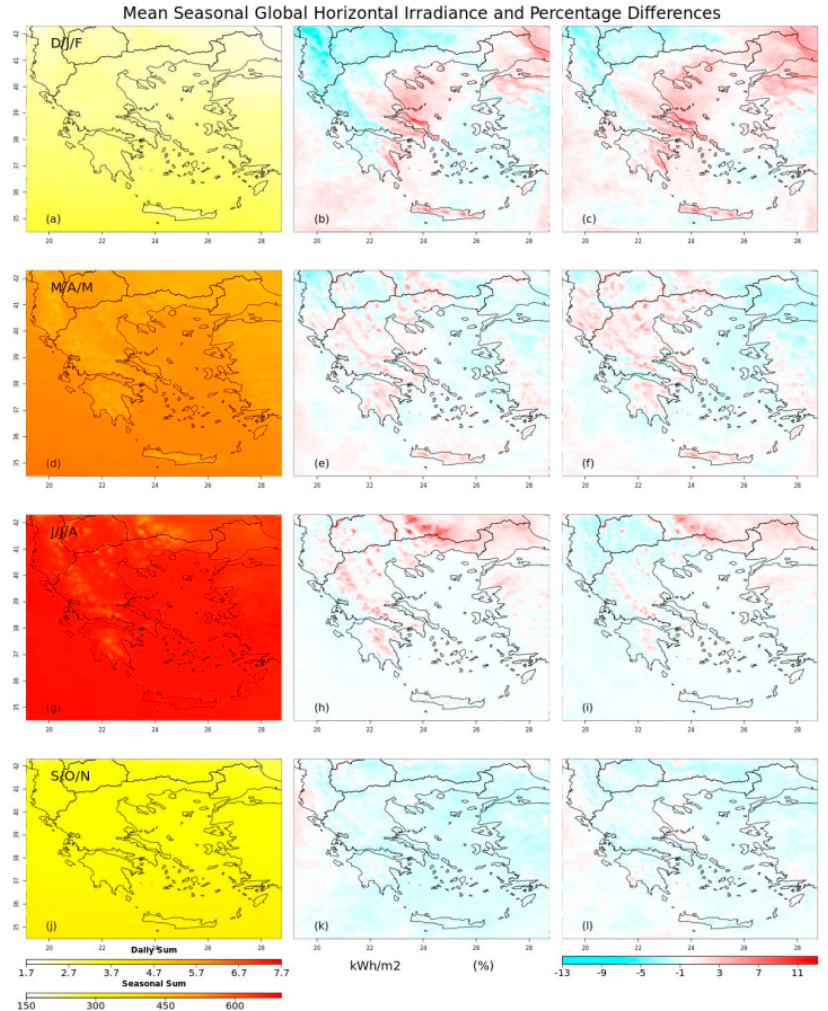
Figure 6. Mean seasonal GHI daily and annual sum ( a , d , g , f ) at historical period and comparison with ( b , e , h , k ) RCP 4.5 and ( c , f , i , l ) RCP 8.5 scenarios.